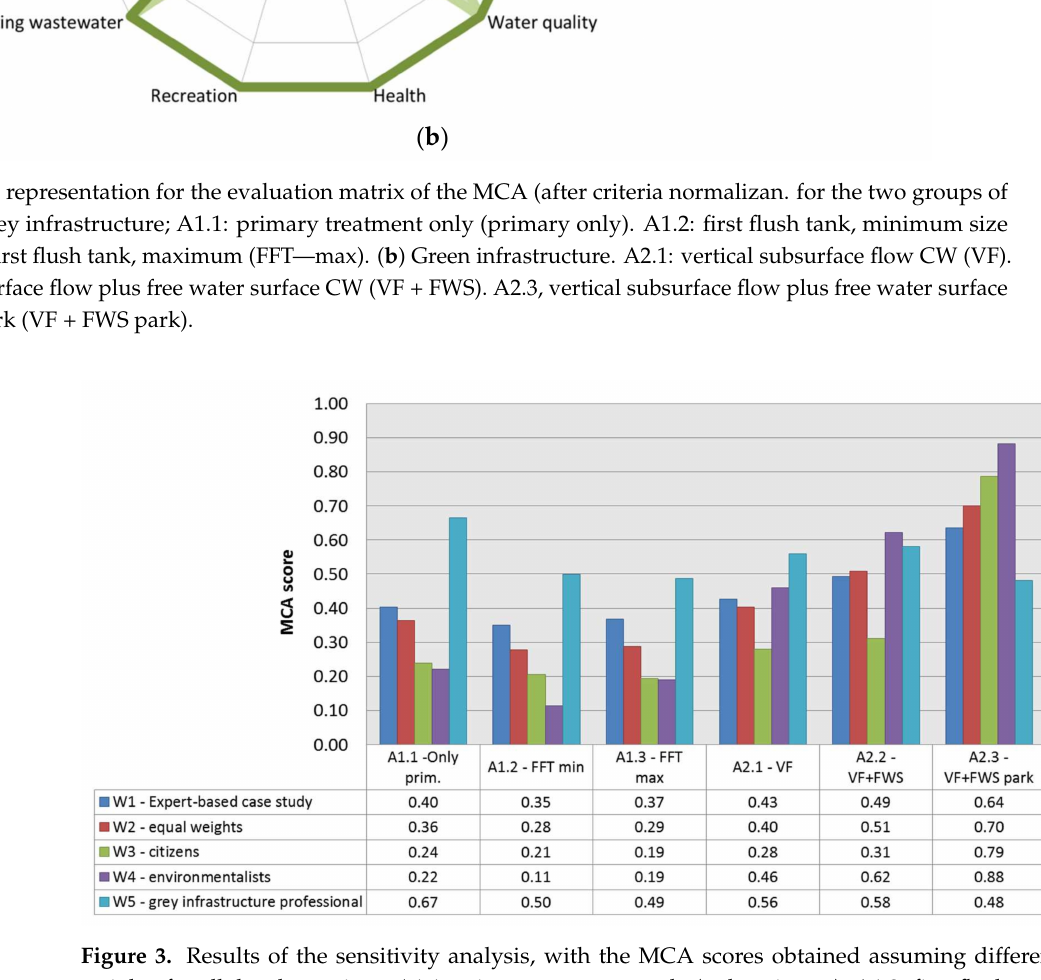
Figure 3. Results of the sensitivity analysis, with the MCA scores obtained assuming different weights for all the alternatives. A1.1: primary treatment only (only primary). A1.2: first flush tank, minimum size (FFT—min). A1.3: first flush tank, maximum (FFT—max). A2.1: vertical subsurface flow CW (VF). A2.2, vertical subsurface flow plus free water surface CW (VF + FWS). A2.3, vertical subsurface flow plus free water surface CW in an urban park (VF + FWS